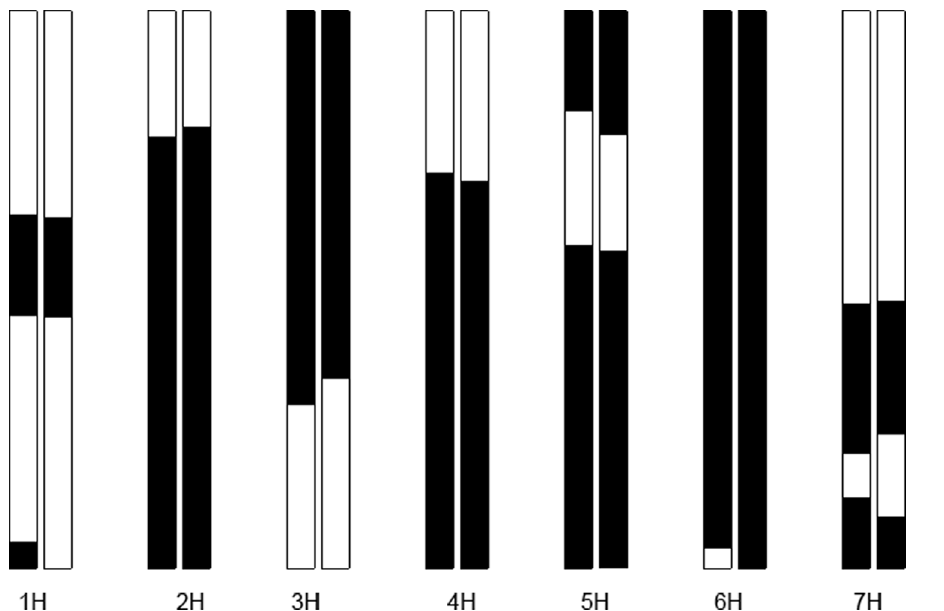
Figure 1. Haplotypes of chromosomes from line SM116 drawn to compare SFP (left) and SNP (right) predictions. Black bars=St chromosomes, white=Mx chromosomes.